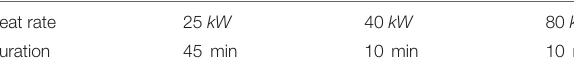
TABLE 2 | Heat rate and duration.